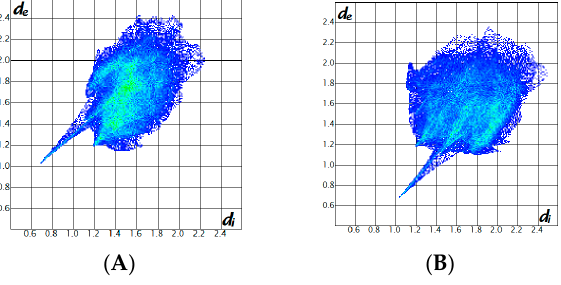
Figure 10. Full fingerprint plot of the cation ( A ) and anion ( B